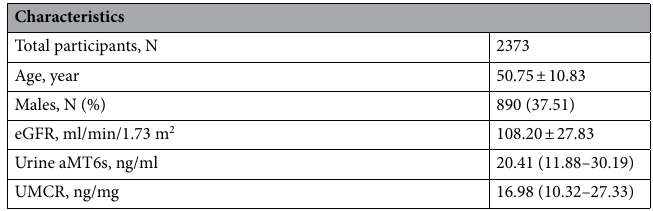
Table 1. Descriptive characteristics of study subjects. Data are mean ± SD, median (IQR) or number (%), as appropriate. Age is at specimen collection. eGFR estimated glomerular filtration rate (by modification of diet in renal disease equation), UMCR urine aMT6s/creatinine ratio.